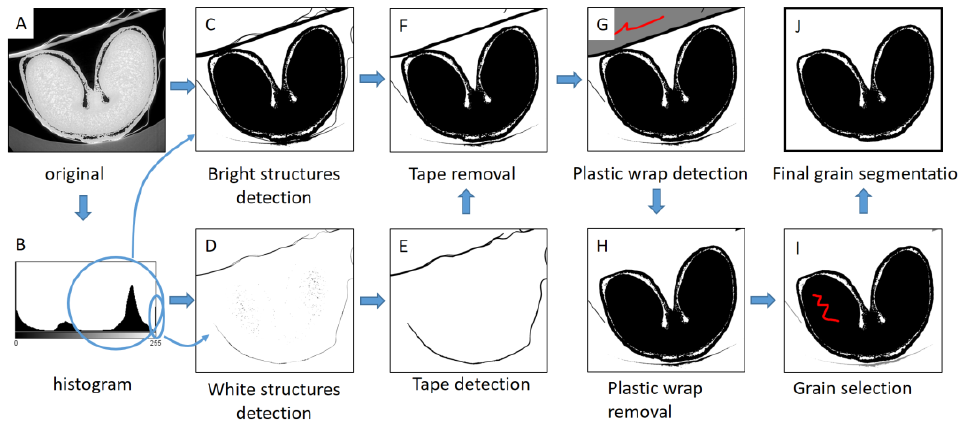
Figure 2. Image processing workflow for segmentation of wheat grain. ( A ) Original (8-bits converted) image. ( B ) Histogram of image gray levels. ( C ) Segmentation of bright structures. ( D ) Segmentation of white structures. ( E ) Selection of the tape voxels. ( F ) Result of tape removal. ( G ) Selection of the region behind the plastic wrap. ( H ) Result of plastic wrap removal. ( I ) Selection of a marker within the grain region. Red color corresponds to the manual selection of binary markers for morphological reconstructions. ( J ) Final segmentation of wheat grain.